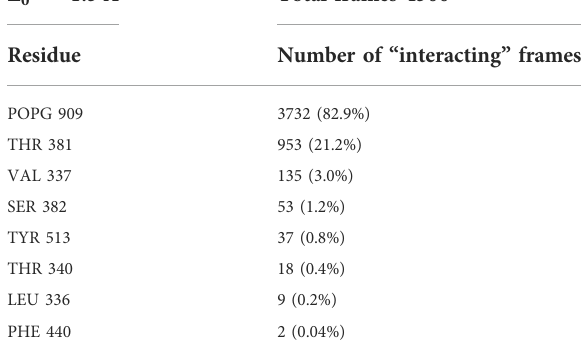
FIGURE 4 Potential of mean force of a K + ion along the permeation pathway in the four wild type nhTMEM16 Systems (see text). The PMFpro fi lesobtained foreachSystemaredepictedwitherrorbars calculated as described in Methods. Z = 0 is set to be the Z position the C α atom of T381 in the protomer. The ranges of “ critical interactions ” in which the K + ion is engaged in > 50% of the trajectory frames in a PMF window are marked by horizontal double-arrowed lines with System-corresponding colors.